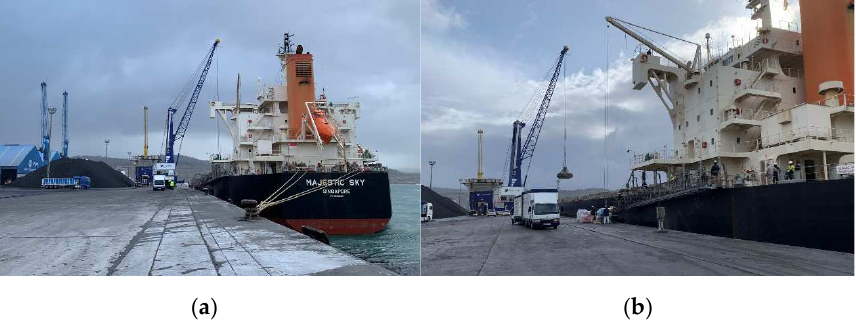
Figure 11. ( a , b ) The vessel Majestic Sky in operations on 14 November 2019 at 12 h (sea state 6172 from Figure 10